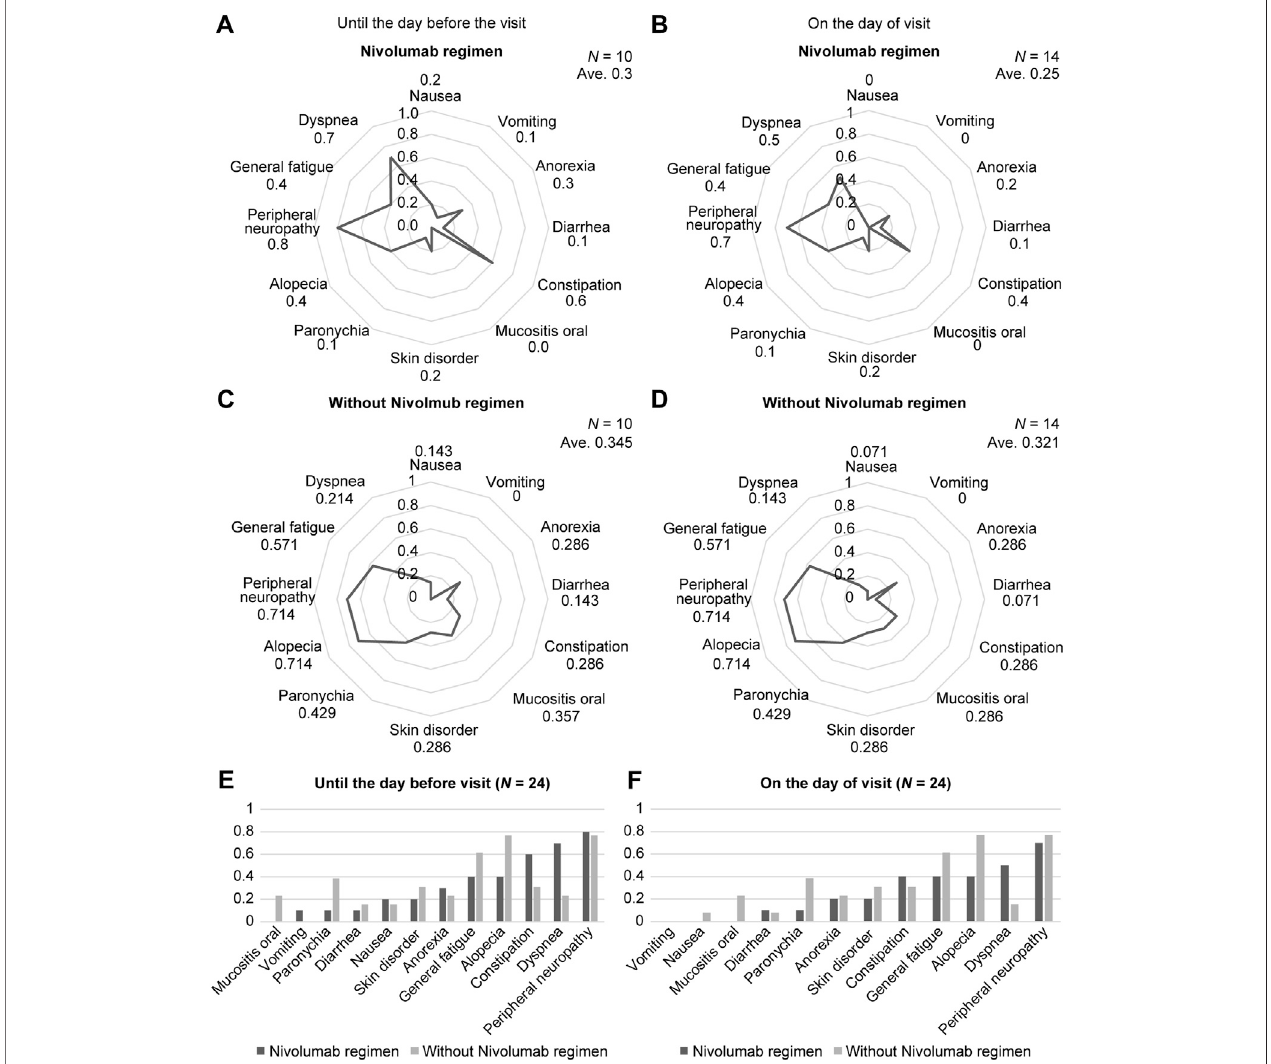
FIGURE3| TheresultsfortheARCsheetusegroupareshown.Assessmentandriskcontrol(ARC)sheetsre fl ectdifferencesinadverseeventsaccordingtodrugs used. (A) : Mean grade of CTCAE for each adverse event in the nivolumab use group up to the treatment date. Up to treatment day, patients in the nivolumab group had lower Common Terminology Criteria for Adverse Events (CTCAE) grades of oral mucositis, diarrhea, skin disorders, paronychia, hair loss, and general malaise than did those in the non-use group. (B) :Mean grade ofCTCAE for each adverse event inthe group using nivolumab on theday oftreatment. On treatment day, patients in the nivolumab group had lower CTCAE grades of nausea, loss of appetite, oral mucositis, skin disorders, paronychia, hair loss, peripheral neuropathy, and general malaise than did those in the non-use group. (C) : Mean grade of CTCAE for each adverse event in the nivolumab-free group up to the treatment date. Up to treatment day, patients in the nivolumab-free group had a CTCAE grade mean for each adverse event compared to patients in the nivolumab-use group. (D) : Mean grade of CTCAE grade for each adverse event in the nivolumab-free group on treatment day. At the treatment date, patients in the nivolumab-free group had a higher mean CTCAE grade for each adverse event. (E) : Comparison of the mean CTCAE grade for each adverse event between the nivolumab-using and non-nivolumab-using groups up to the date of treatment. The severity of mouth ulcers and paronychia up to treatment day is signi fi cantly different between patients who received nivolumab and those who did not. (F) : Comparison of the mean grade of CTCAEs for each adverse event between the nivolumab-using and non-nivolumab-using groups on the dayoftreatment.Theseverityofmouthulcersandparonychiaontreatmentdayissigni fi cantlydifferentbetweenpatientswhoreceivednivolumabandthosewhodidnot.